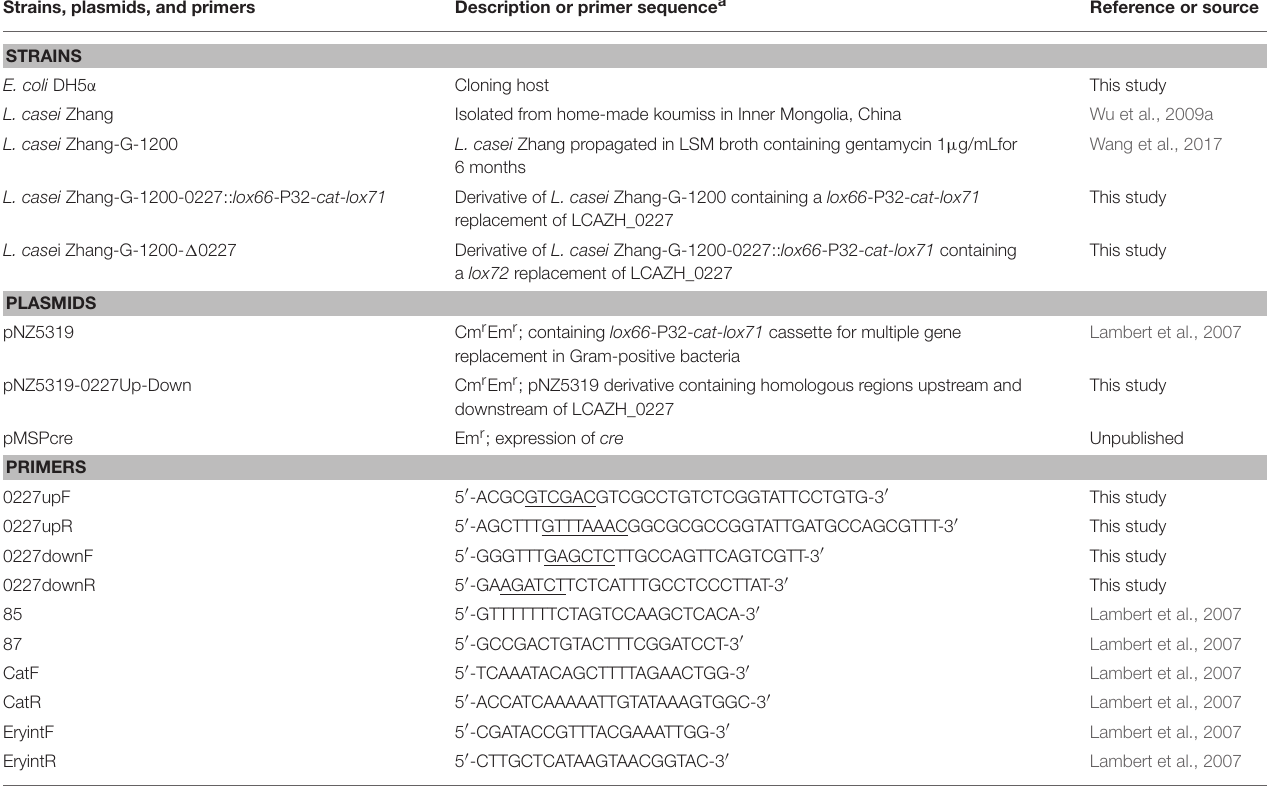
TABLE 1 | Strains, primers, and plasmids used for constructing the gene disruption